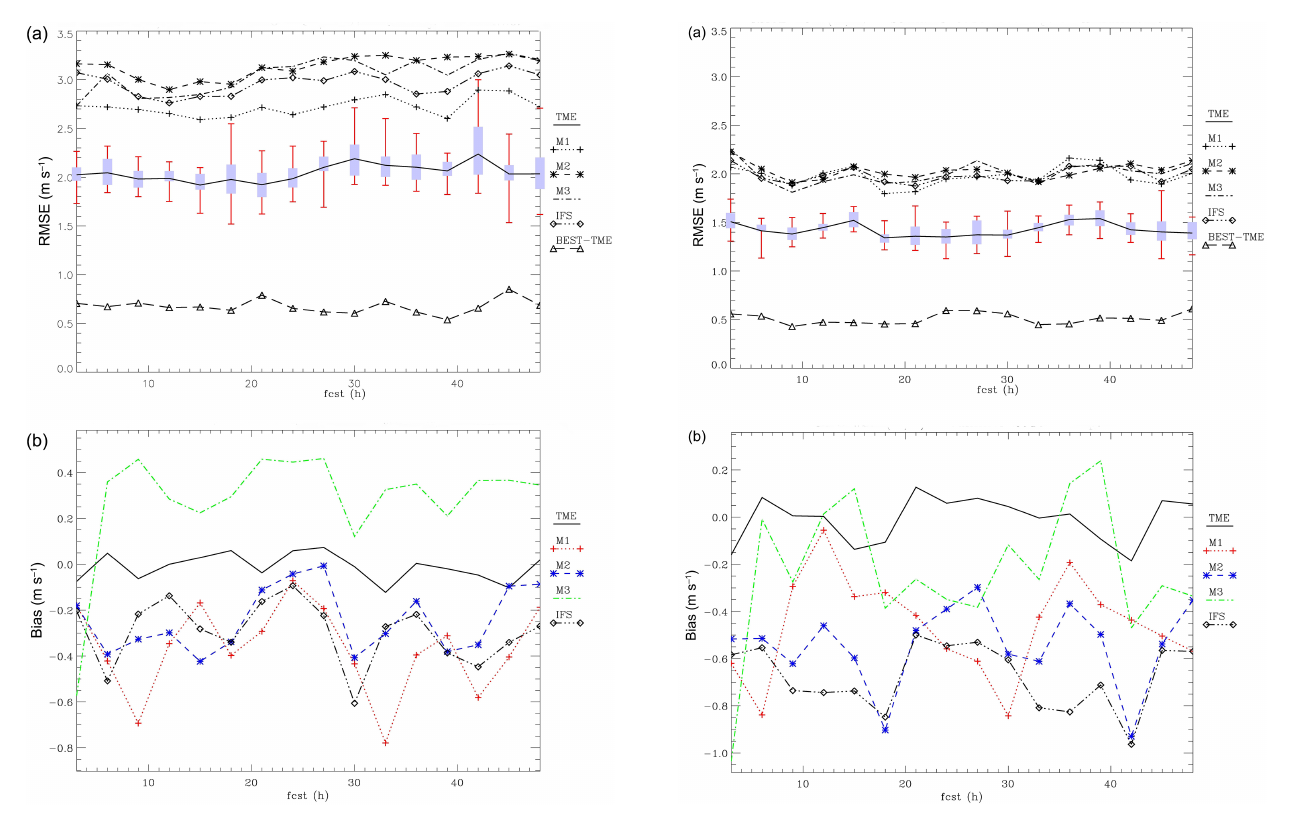
Figure 3. RMSE (a) and bias (b) for the winter wind speed versus forecast time. M1, M2, and M3 are the three models forming the TME, while the IFS model is shown for comparison. The difference between the RMSE of the best model (of M1–M3) and that of the TME is also shown in (a) . The boxes on the TME RMSE curve show the 25th and 75th percentile of the RMSE distribution for the 20 attempts, while the error bars extend between the maximum and minimum value of the RMSE for the 20 attempts.